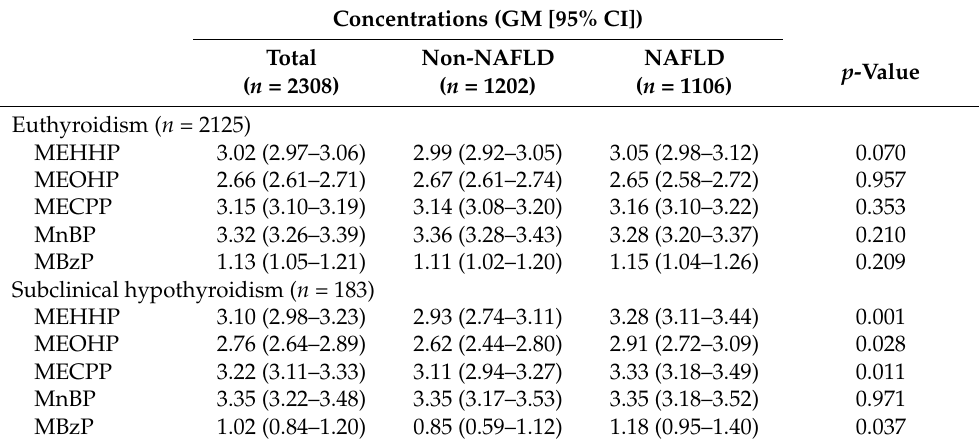
Table 4. The average of the urinary phthalate metabolite levels (log transformed, µ g/L) in the study